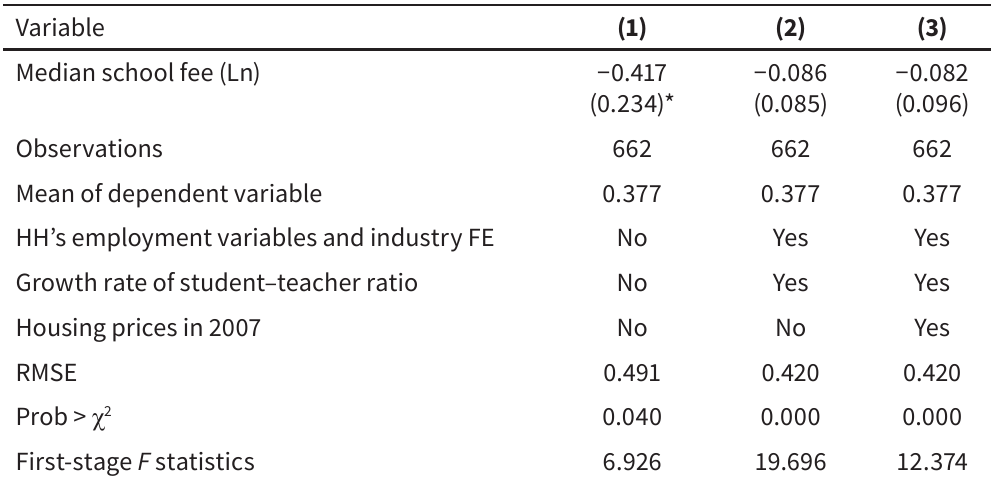
Effects of median school fees on the gender of children brought to the city, China